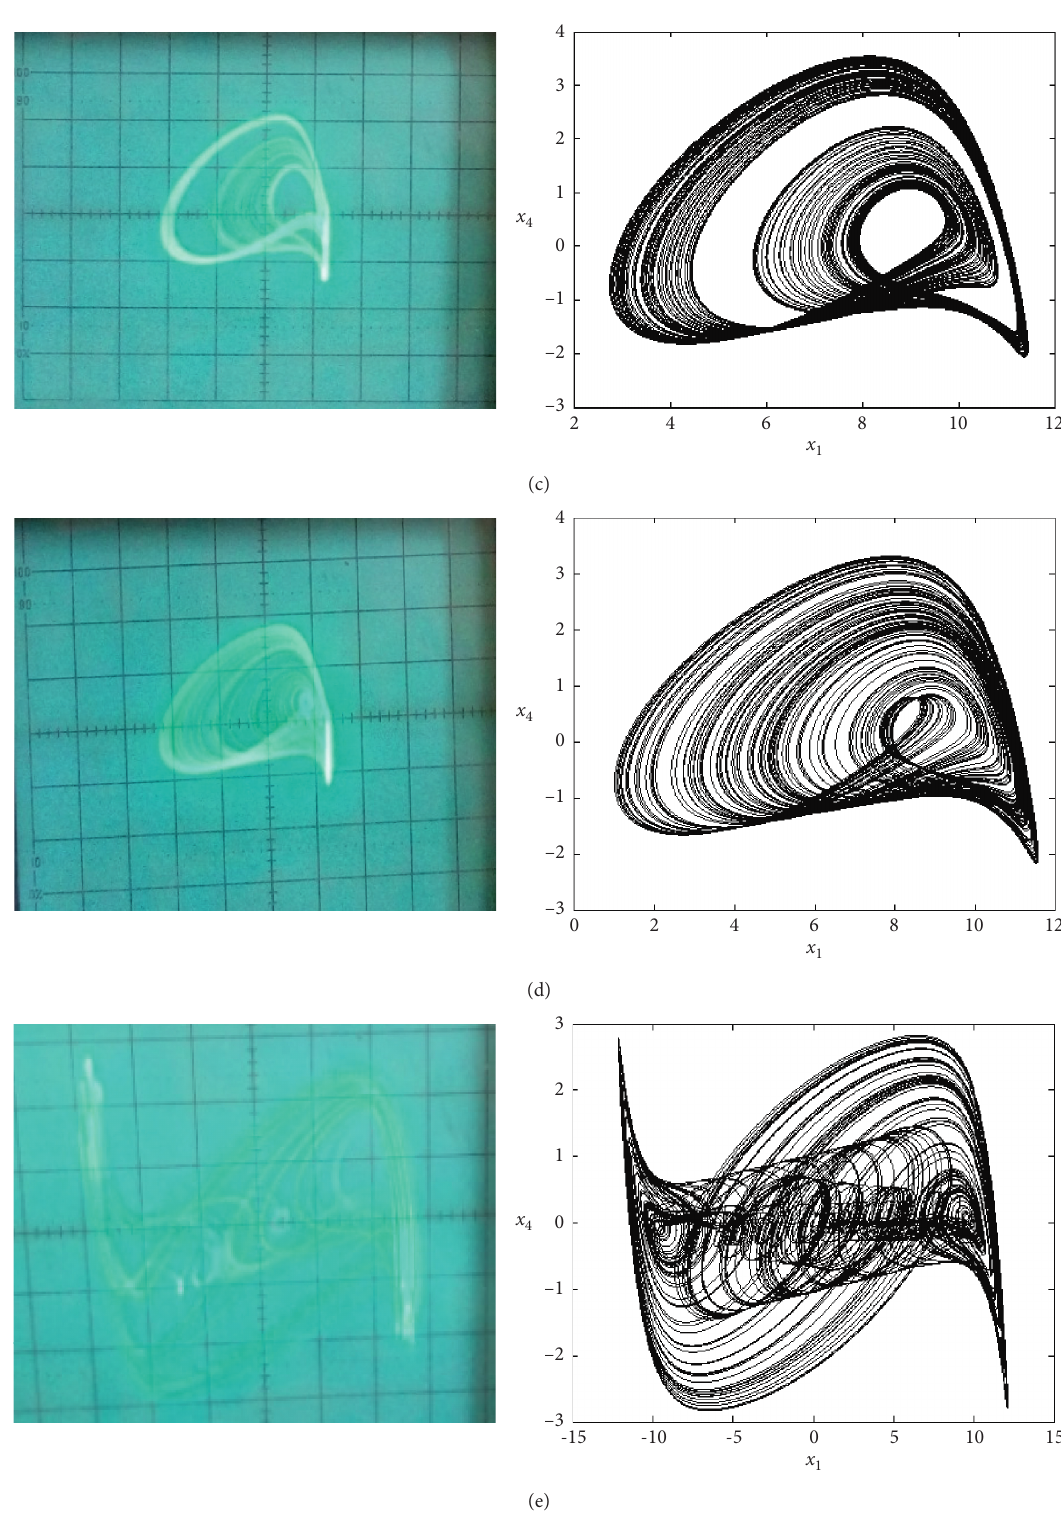
Figure 21: Experimental phase portraits (right column) and corresponding numerical ones (left column) obtained by a direct integration of the system (1) confirming the scenario to chaos in the system for varying Ra (i.e., parameter a ): (a) period-1 for R a � 1 . 428, (b) period-2 for � 807, (c) single-band chaos for R � 684, (d) single–band chaos for R � 500, and (e) double-band chaos for R R a a a X � 0 . 2 V / div and Y � 0 . 5 V / div